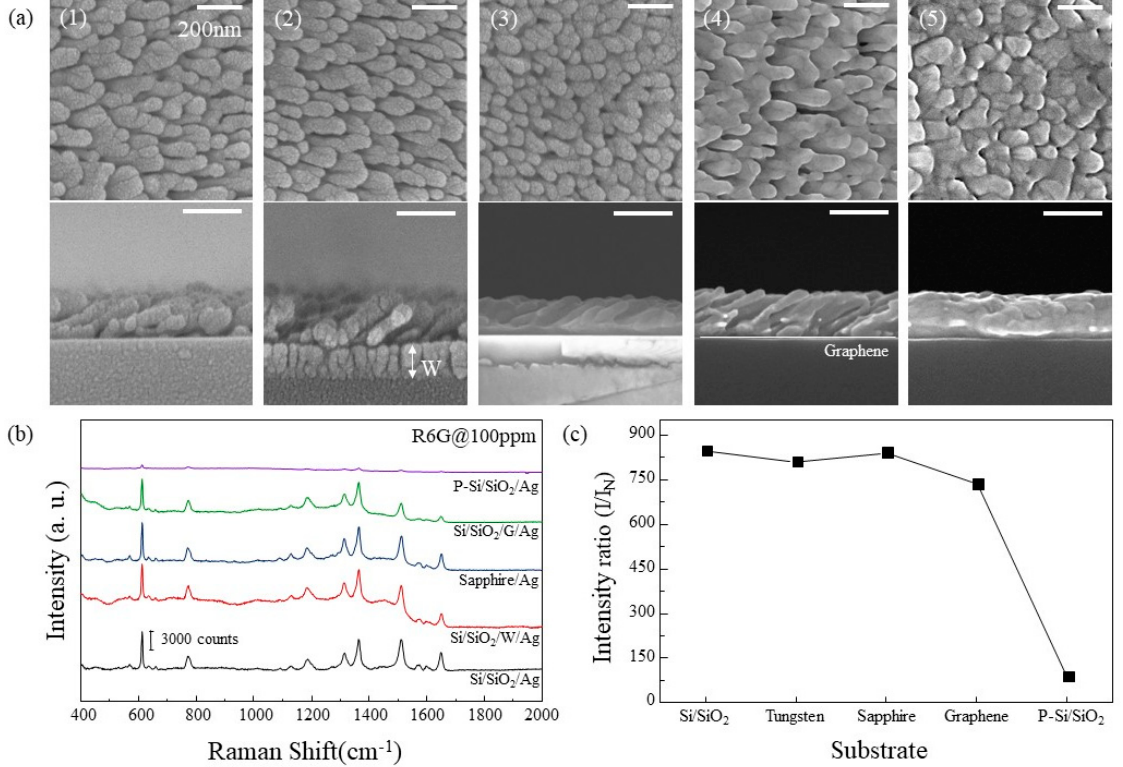
Figure 3. ( a ) Top view( upper ) and cross-section( below ) SEM images of Ag nanorods arrays deposited on different substrates at 2.4 Å/s of deposition rate. ( 1 ) Si/SiO 2 , ( 2 ) Si/SiO 2 /W, ( 3 ) Sapphire, ( 4 ) Si/SiO 2 /G, and ( 5 ) P-Si/SiO 2 . ( b ) SERS spectra of R6G absorbed on Ag in ( a ). ( c ) SERS efficiency of each Ag substrate.